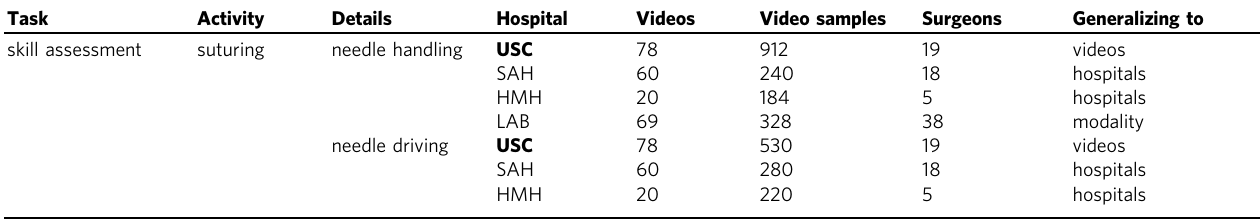
Table 1 Total number of videos and video samples associated with each of the hospitals and